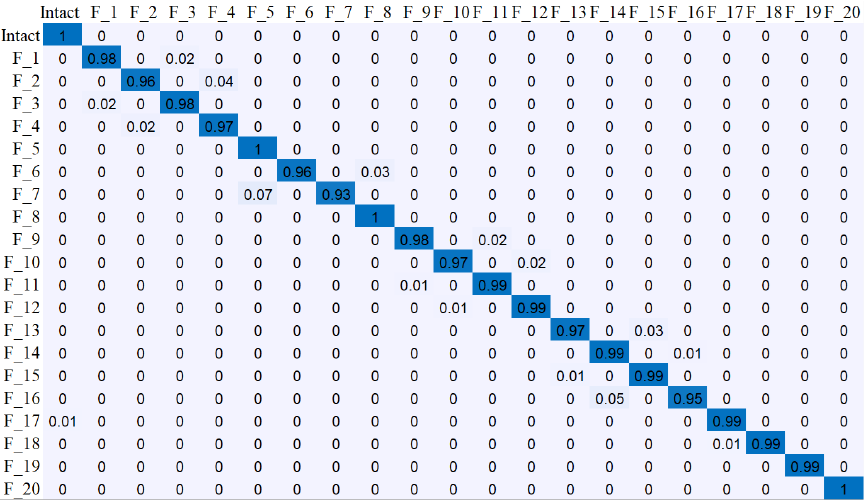
Figure 15. Failure detected location when there are 5 sensors at points 2, 4, 5, 6, and 8 (Accuracy: 96.7%).